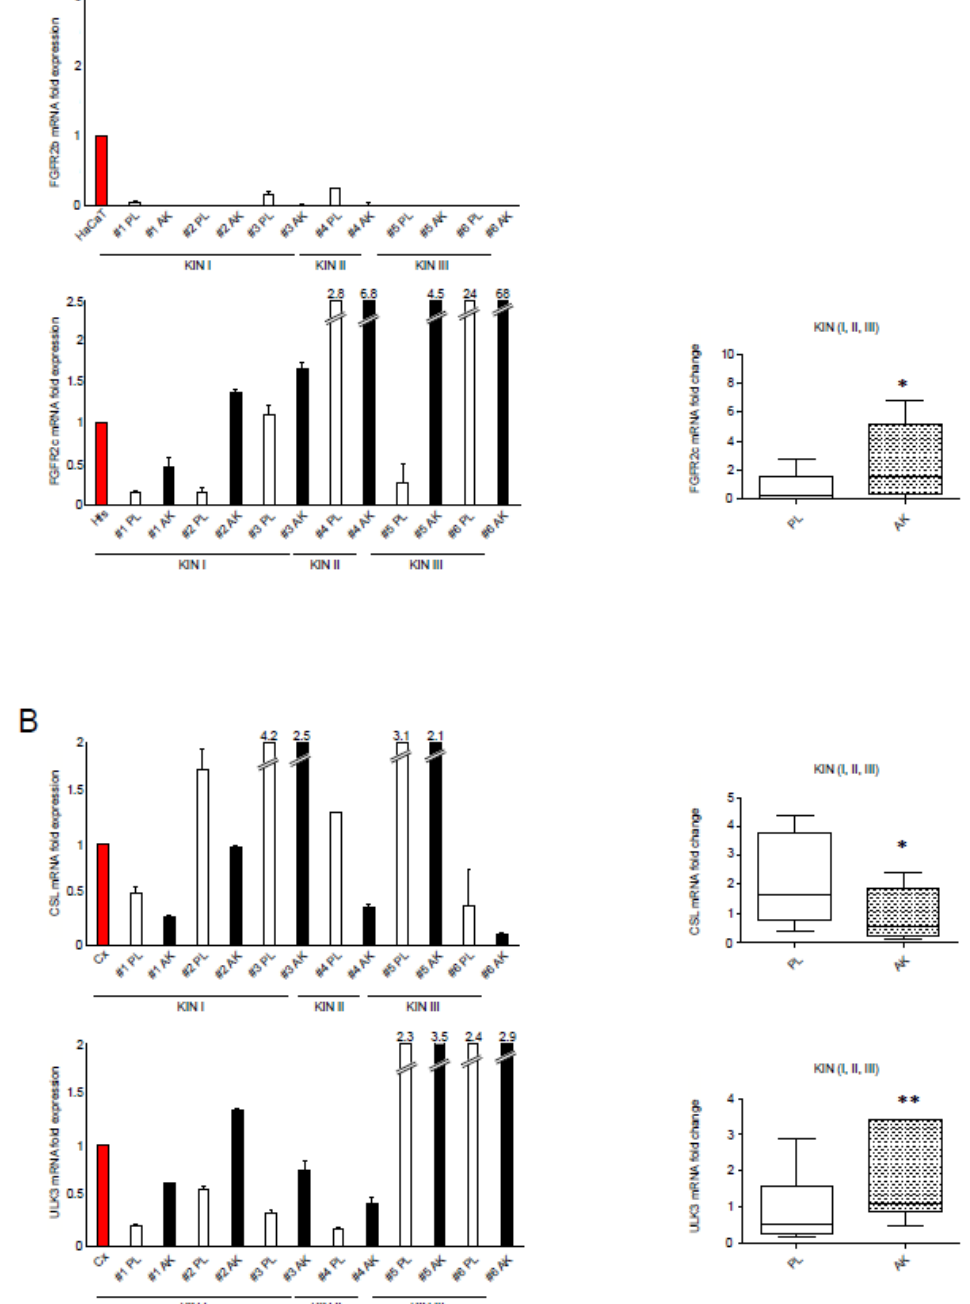
Figure 1. Expression of FGFR2 isoforms and CAF gene regulators CSL and ULK3 in the dermal portion of KIN I, KIN II, and KIN III samples. Epidermal FGFR2b isoform ( A ), mesenchymal FGFR2c isoform ( A ), CSL ( B ), and ULK3 ( B ) mRNA levels were evaluated by real-time RT-PCR in KIN I, KIN II, and KIN III samples (PL—perilesional samples, white bars; AK—lesional samples, black bars) and normalized respect to HaCaT cells, HFs or the mean of all the perilesional values (Cx, red bar) as reported in the graph. Results are expressed as mean ± standard deviation (SD). Statistical analysis of relative expression rates of KIN I + KIN II + KIN III AK versus KIN + KIN I + KIN III PL samples was performed using Wilcoxon rank-sum test, and significance levels were defined as p < 0.05. * p < 0.05; ** p < 0.01 versus the corresponding PL